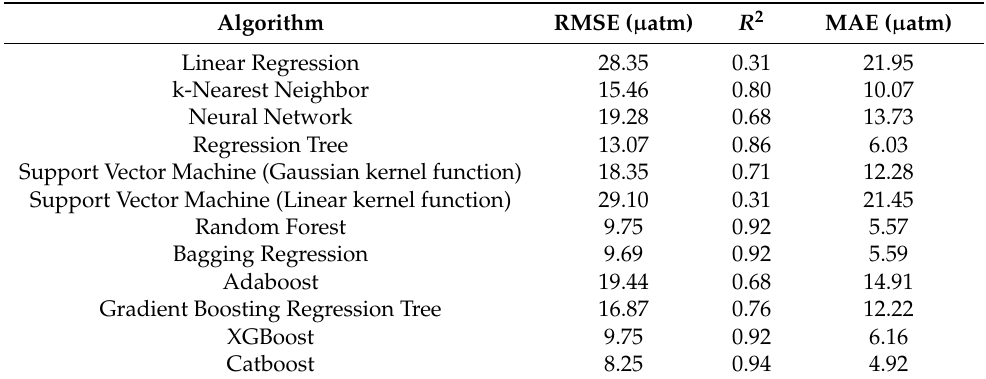
Table 2. The performance of different machine learning methods on pCO 2 estimation using the val- idation set.